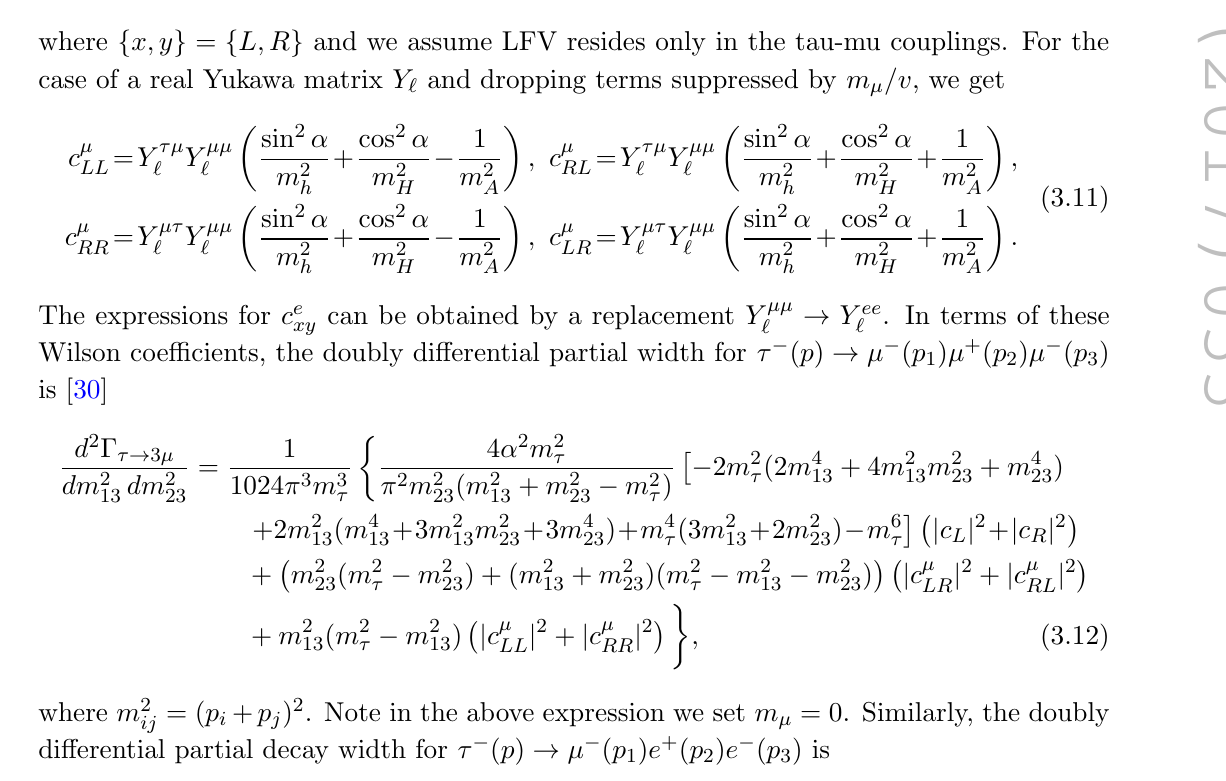
Figure 8. The diagrams contributing to (cid:28) the e(cid:11)ective dipole operators in eq.